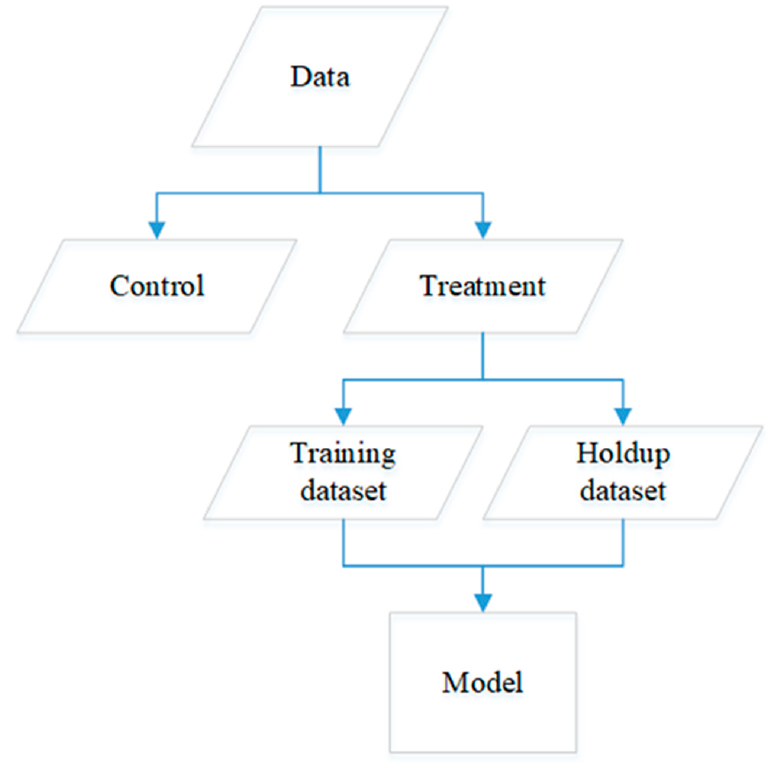
Figure 2. Uplift Two-model Approach.